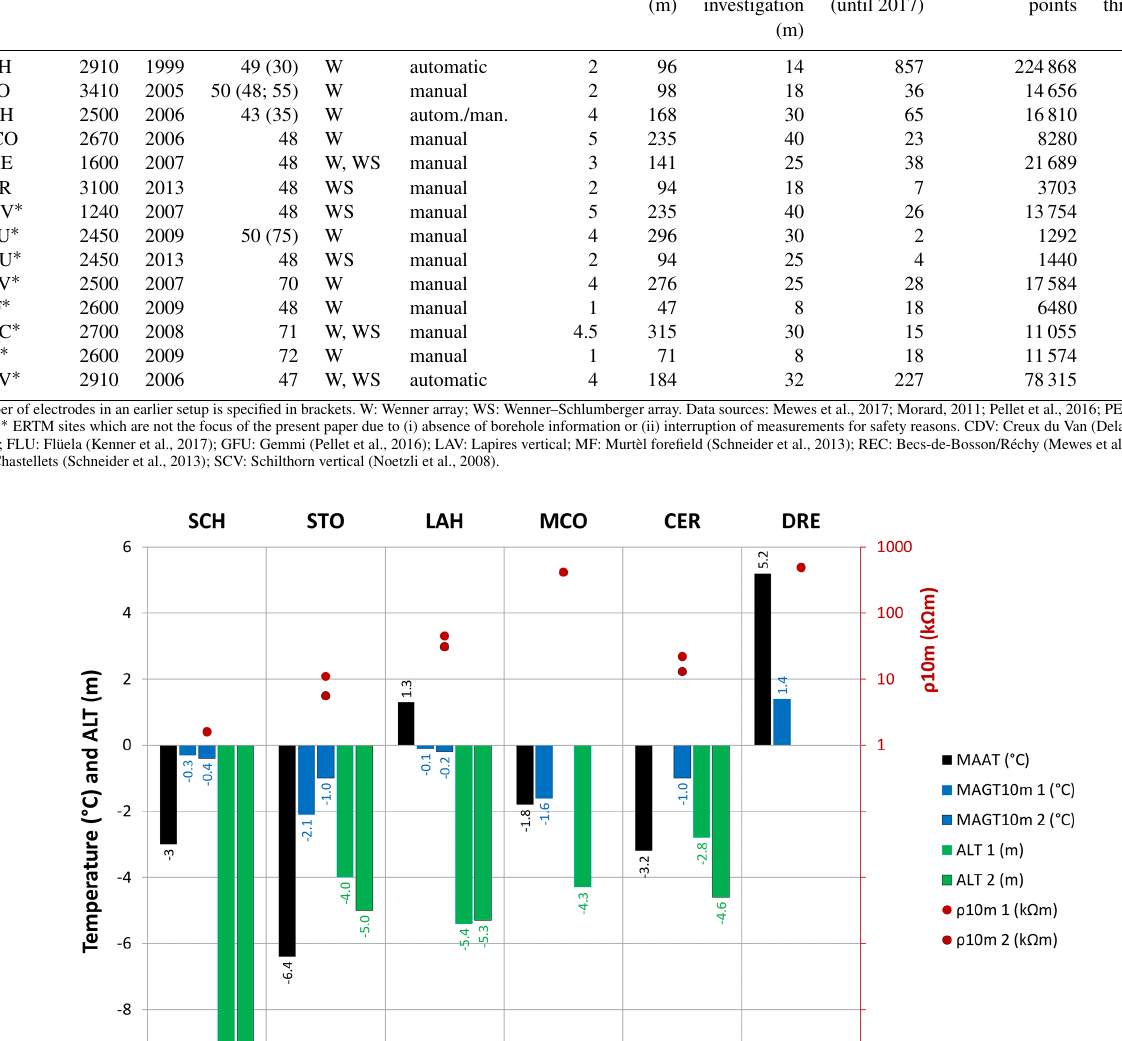
Table 1. Key information of the geophysical monitoring installations. Altitude Start Number of Config. Acquisition Spacing Profile (ma.s.l.)